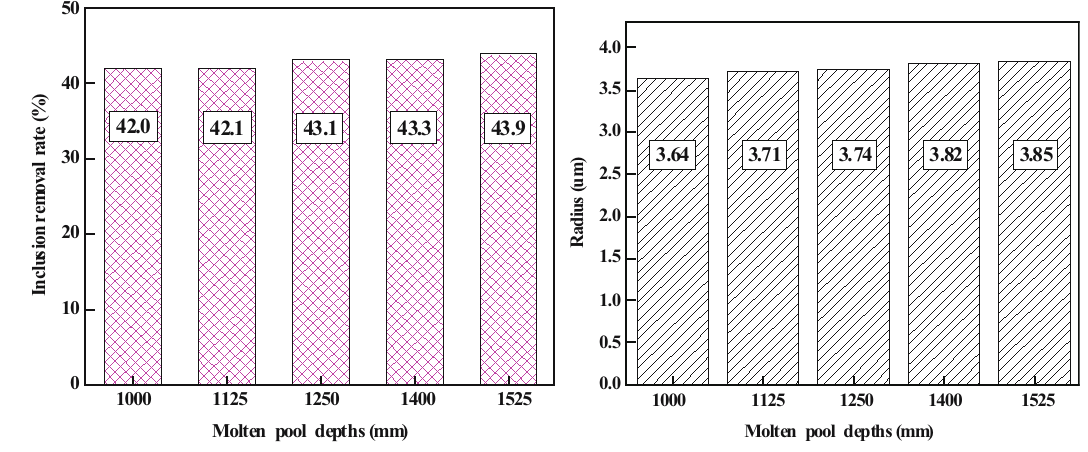
Figure 2: Inclusion removal rate and characteristic inclusion radius of tundish with di ff erent molten pool